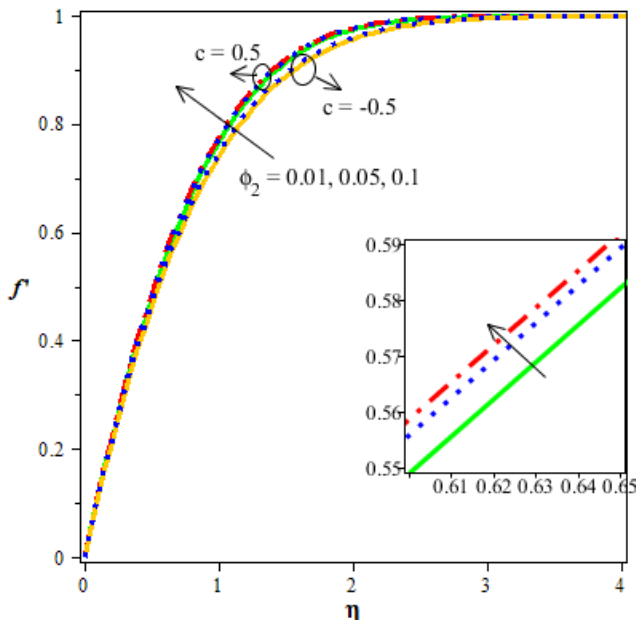
Figure 7. The curve f (cid:48) ( η ) on φ 2 .